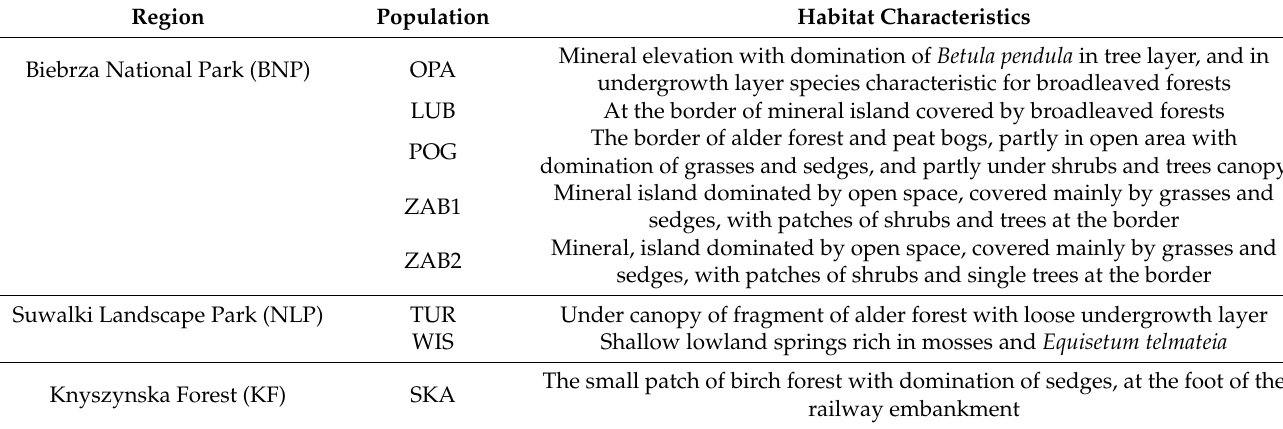
Table 8. Habitat characteristics for Neottia ovata populations in northeast Poland. Region Population Habitat Characteristics Mineral elevation with domination of Betula pendula in tree layer, and in Biebrza National Park (BNP) OPA undergrowth layer species characteristic for broadleaved forests LUB At the border of mineral island covered by broadleaved forests The border of alder forest and peat bogs, partly in open area with POG domination of grasses and sedges, and partly under shrubs and trees canopy Mineral island dominated by open space, covered mainly by grasses and ZAB1 sedges, with patches of shrubs and trees at the border Mineral, island dominated by open space, covered mainly by grasses and ZAB2 sedges, with patches of shrubs and single trees at the border Suwalki Landscape Park (NLP) TUR Under canopy of fragment of alder forest with loose undergrowth layer WIS Shallow lowland springs rich in mosses and Equisetum telmateia The small patch of birch forest with domination of sedges, at the foot of the Knyszynska Forest (KF) SKA railway